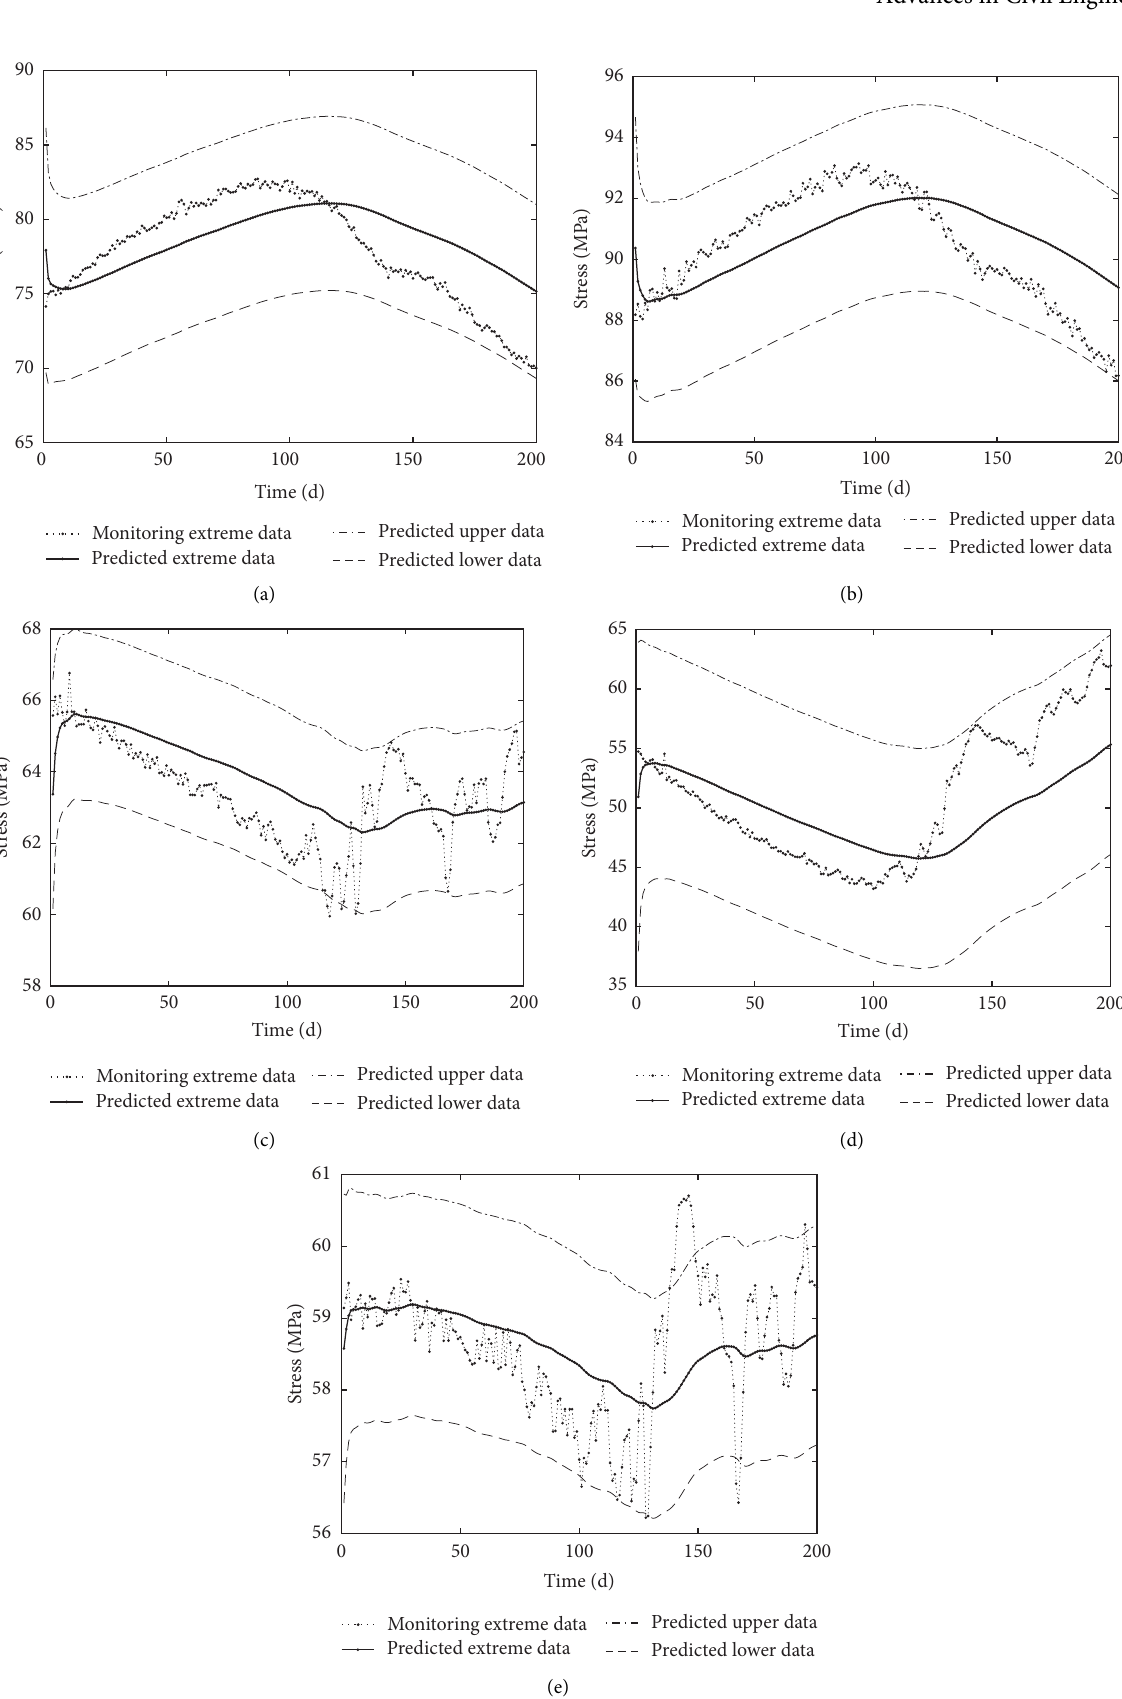
Figure 6: Predicted extreme stresses of the five sections. (a) Section A. (b) Section B. (c) Section C. (d) Section D. (e) Section